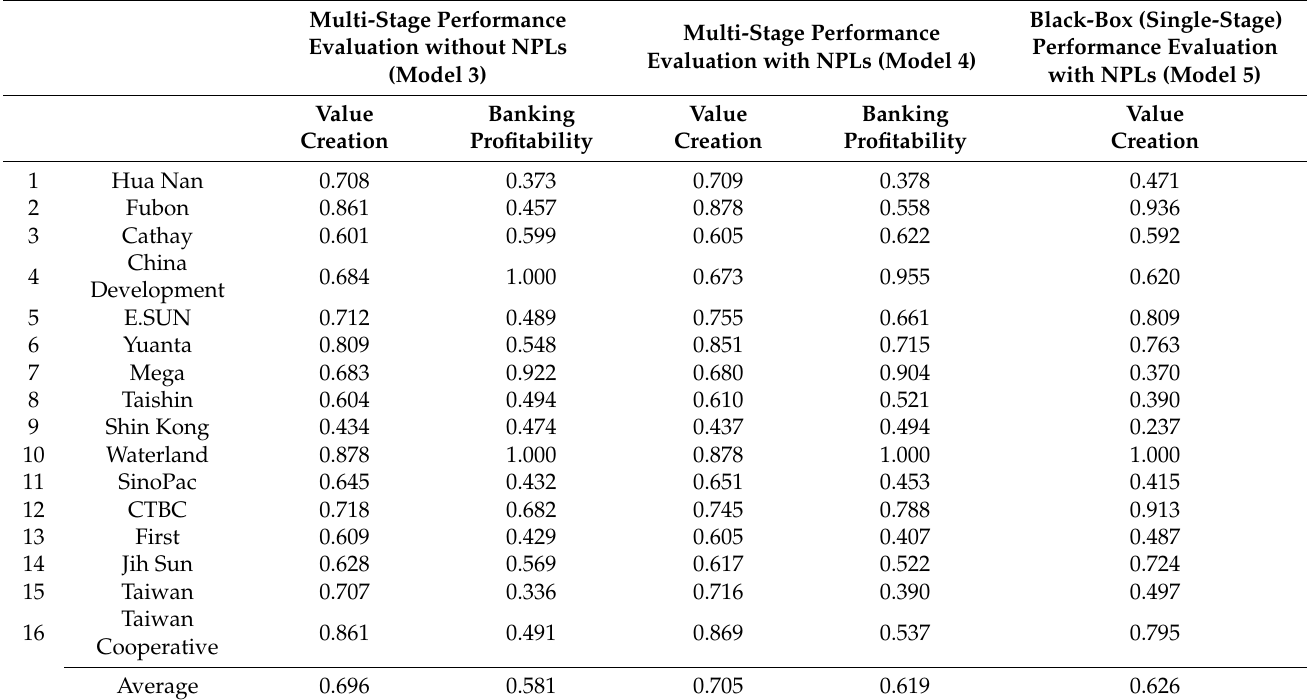
Table 11. Overall value creation and banking profitability performance with or without